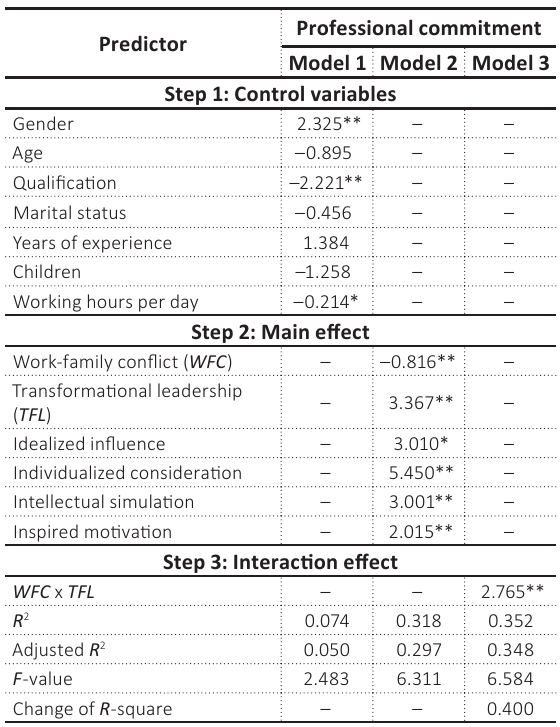
Table 3. Moderated regression